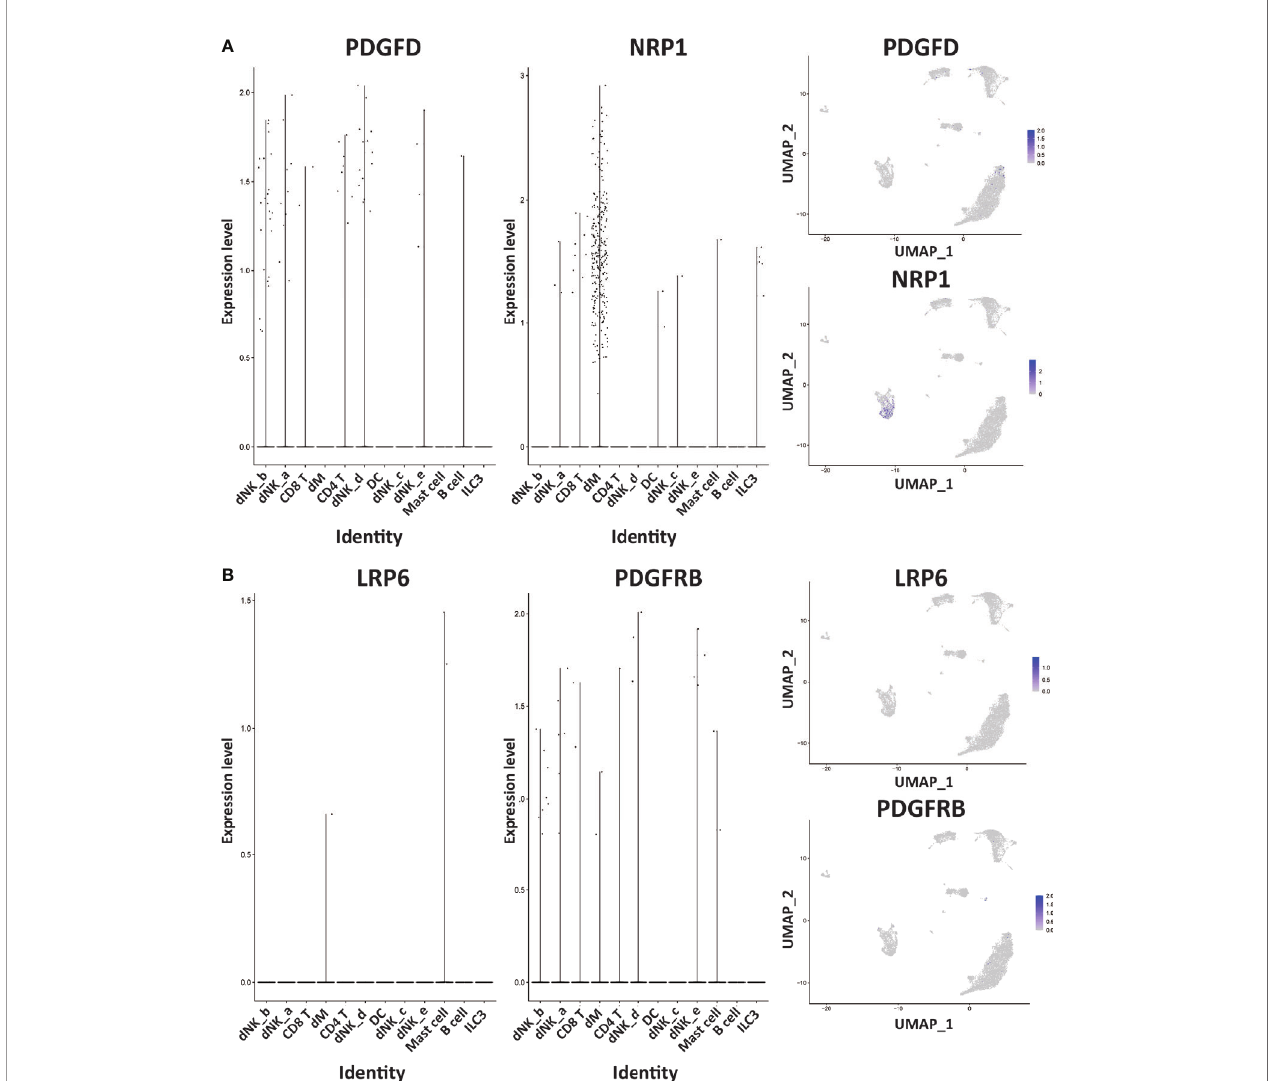
FIGURE 4 | The expression of DEGs in the immune cells of normal decidua. (A) The violin plots and the UMAP visualization maps showing the expression of two up-regulated DEGs (PDGFD and NRP1) in the immune cells of normal decidua. (B) The violin plots and the UMAP visualization maps showing the expression of two up-regulated DEGs (LRP6 and PDGFRB) in the immune cells of normal decidua. dM, decidual macrophages; dNK, decidual natural killer cells; ILC, innate lymphoid cells; DC, dendritic